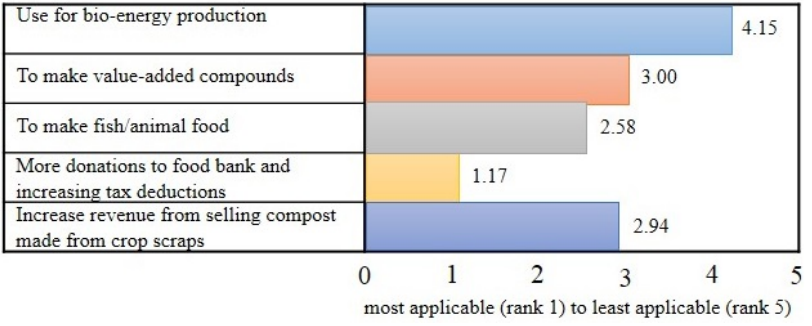
Figure 6. Food loss utilization categories and mean rankings from participant responses.